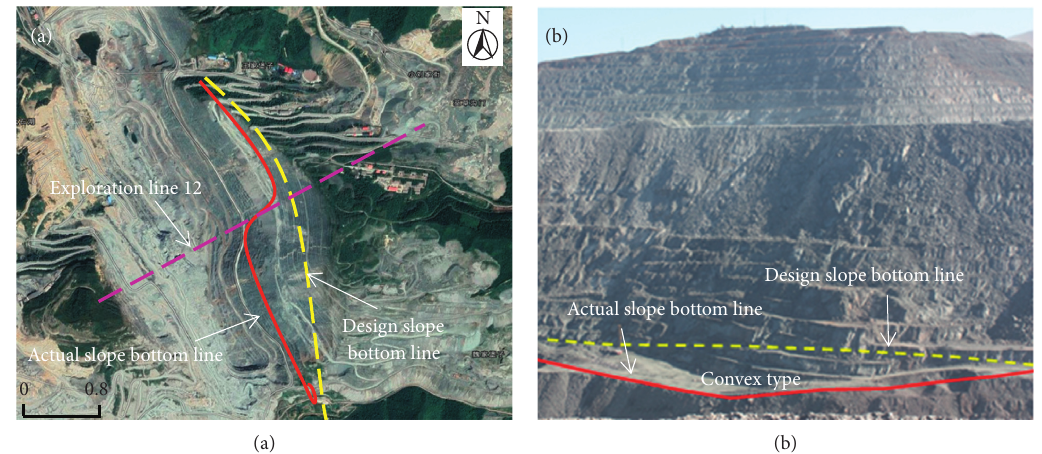
Figure 1: Images showing the convex slope. (a) Satellite imagery (N41 ° E123 ° ). (b) Entity diagram.